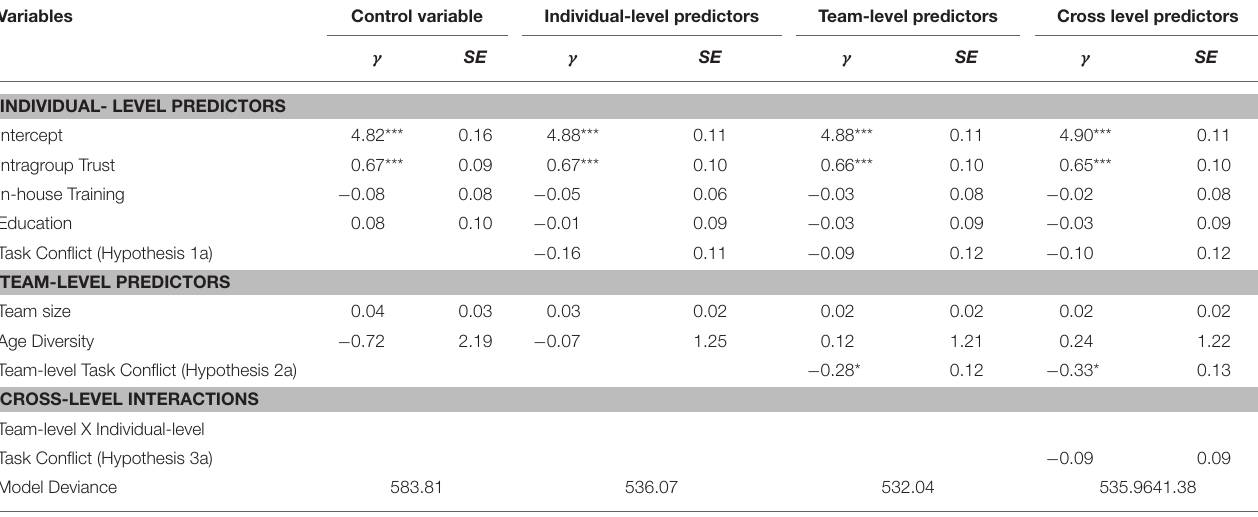
TABLE 3 | HLM results for the effects of task conflict on team commitment.